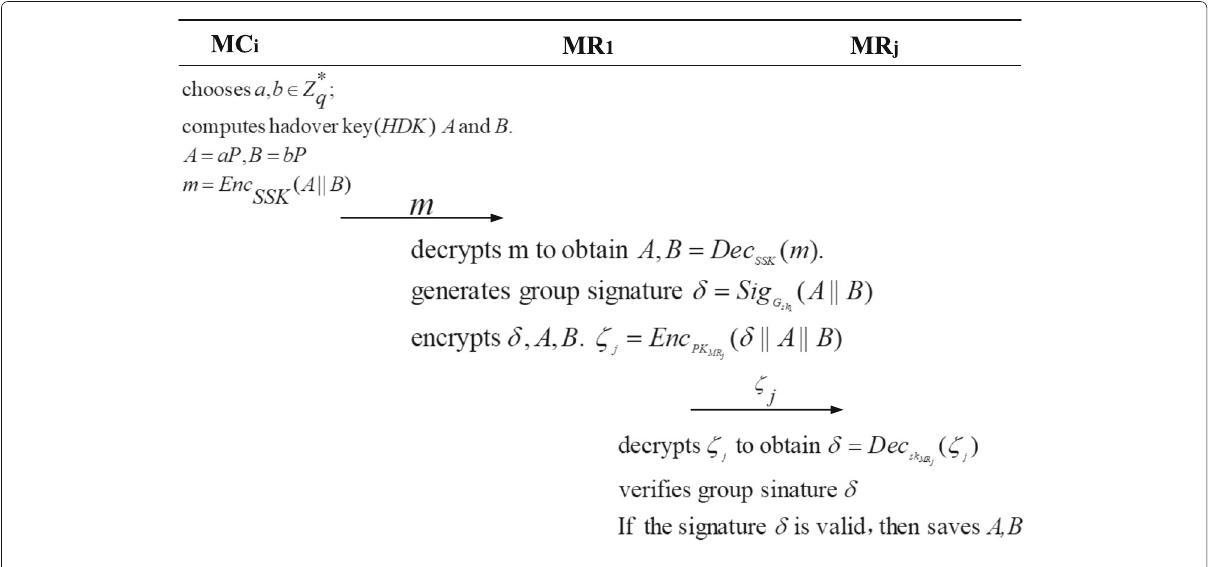
Fig. 2 Pre-distribution of handover authentication key phase. This figure describes the parameters exchanged in the pre-distribution of handover